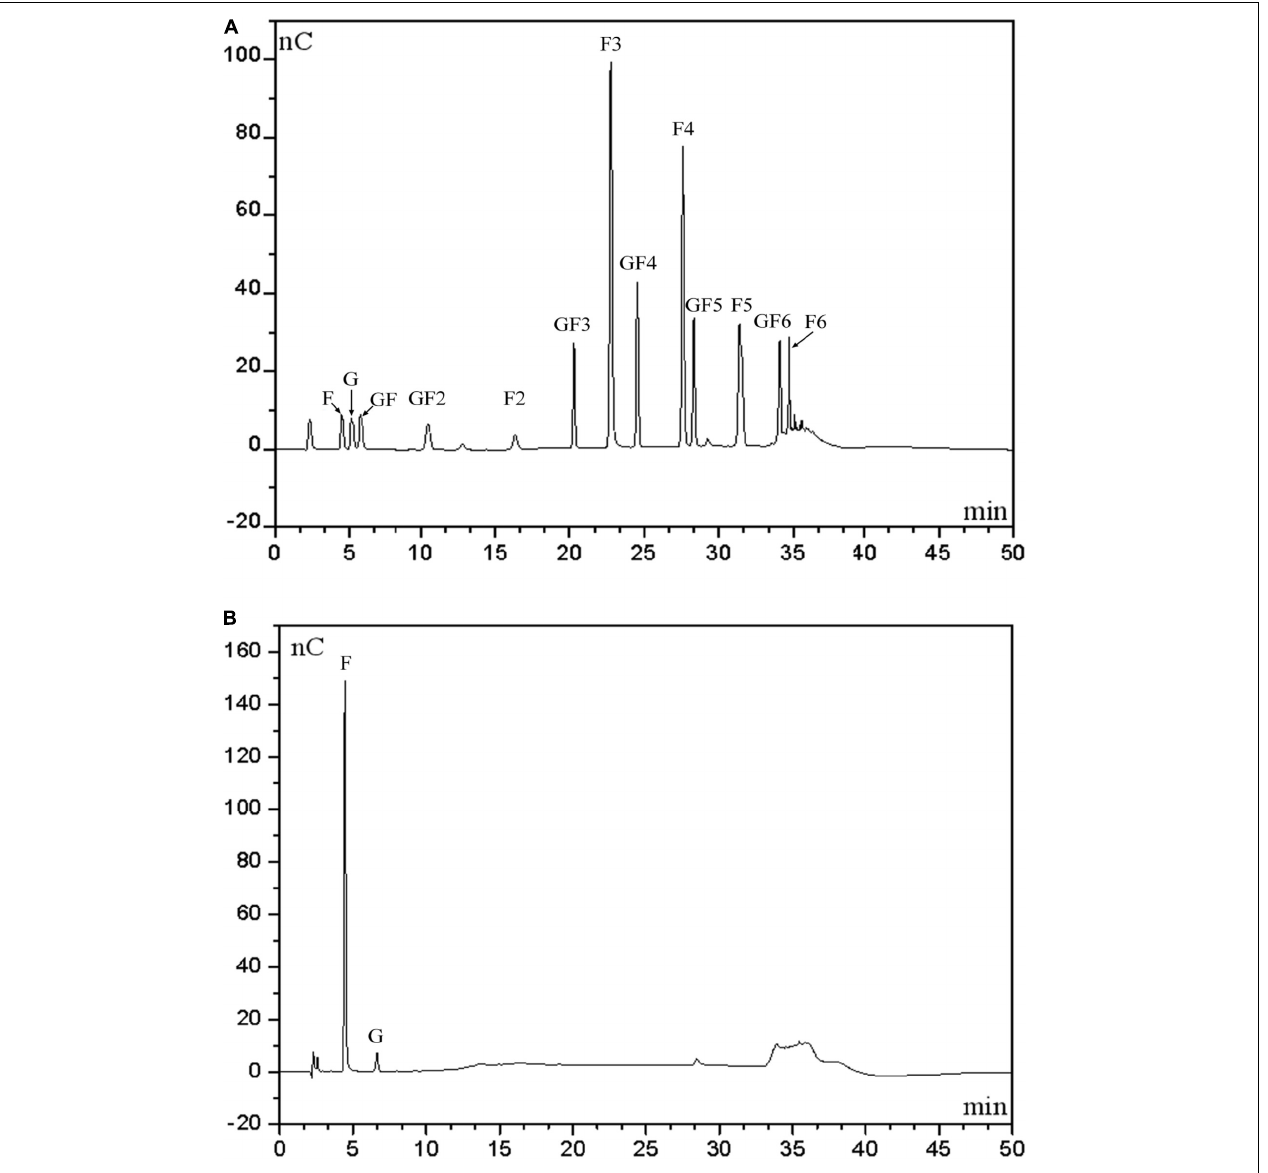
FIGURE 6 | High-performance anion exchange chromatography of inulin hydrolysis products using fractionated endo-inulinase (A) and natural inulinase. (B) The hydrolysis conditions were: 40 g/L inulin, pH 4.6, enzyme loading 40 U/(g inulin) and 50 ◦ C. Abbreviations: glucose, G; sucrose, GF; 1-kestose, GF2; 1-nystose, GF3; 1-F-1- β -D-fructofuranosyl nystose, GF4; 1-F-(1- β -D-fructofuranosyl) -2-nystose, GF5; 1-F-(1- β -D-fructofuranosyl)-3-nystose, GF6; fructose, F; inulobiose, F2; inulotriose, F3; inulotetraose, F4; inulopentaose, F5; inulohexaose,